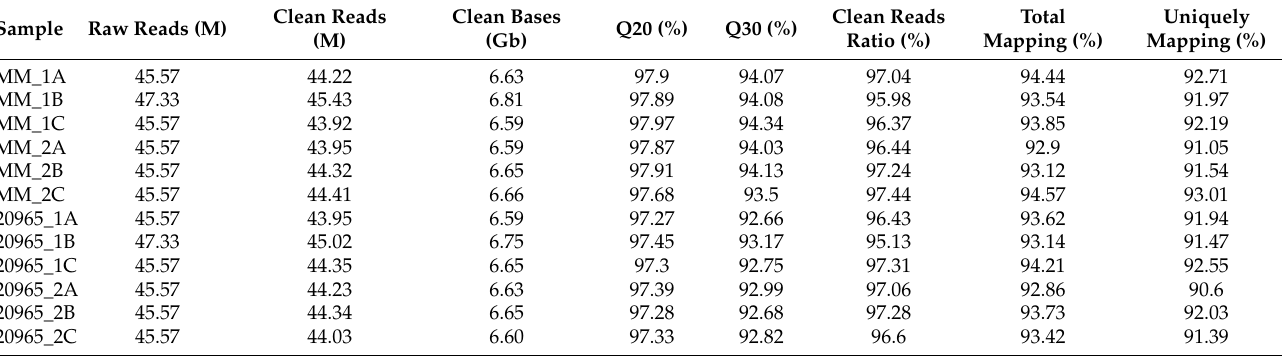
Table 1. Statistics of the Solanum lycopersicum transcriptome